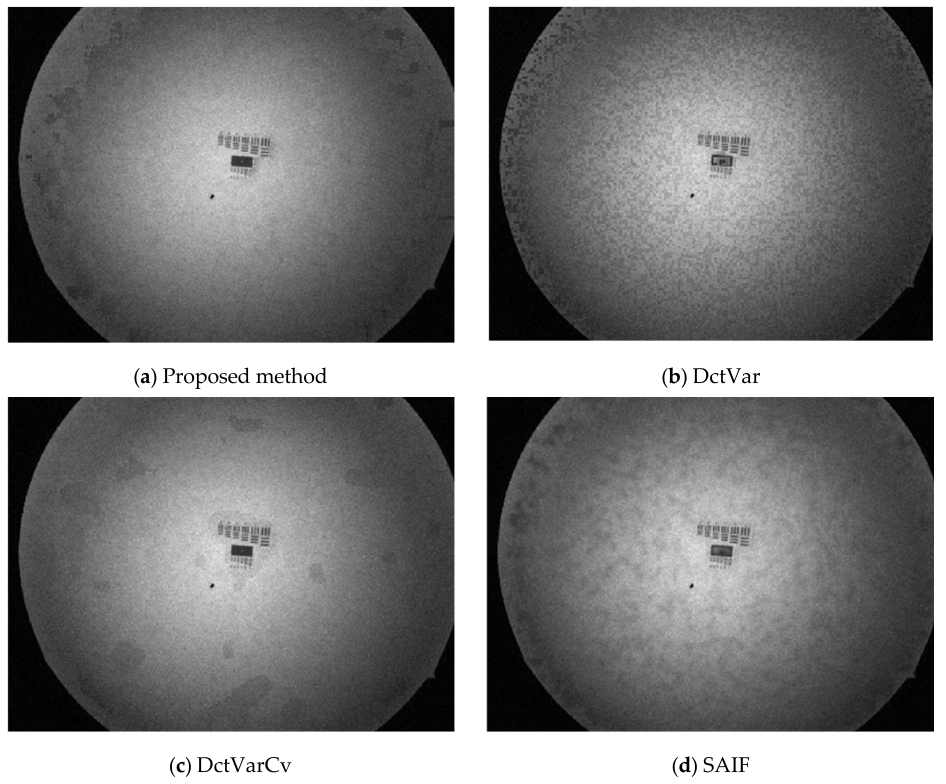
Figure 16. The fusion result of the NVG image (61 and 96 degrees). Appl. Sci. 2019 , 9 , x FOR PEER REVIEW